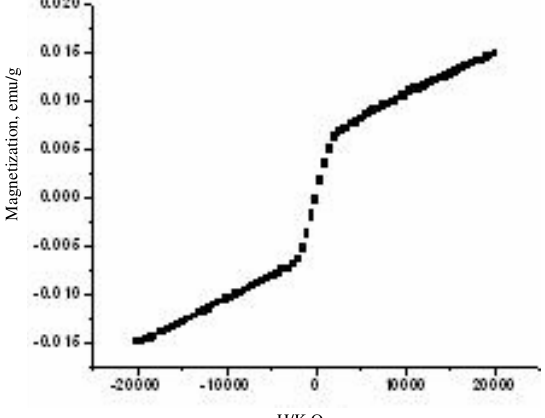
Figure 8. Magnetic property of the as-prepared NiTiO